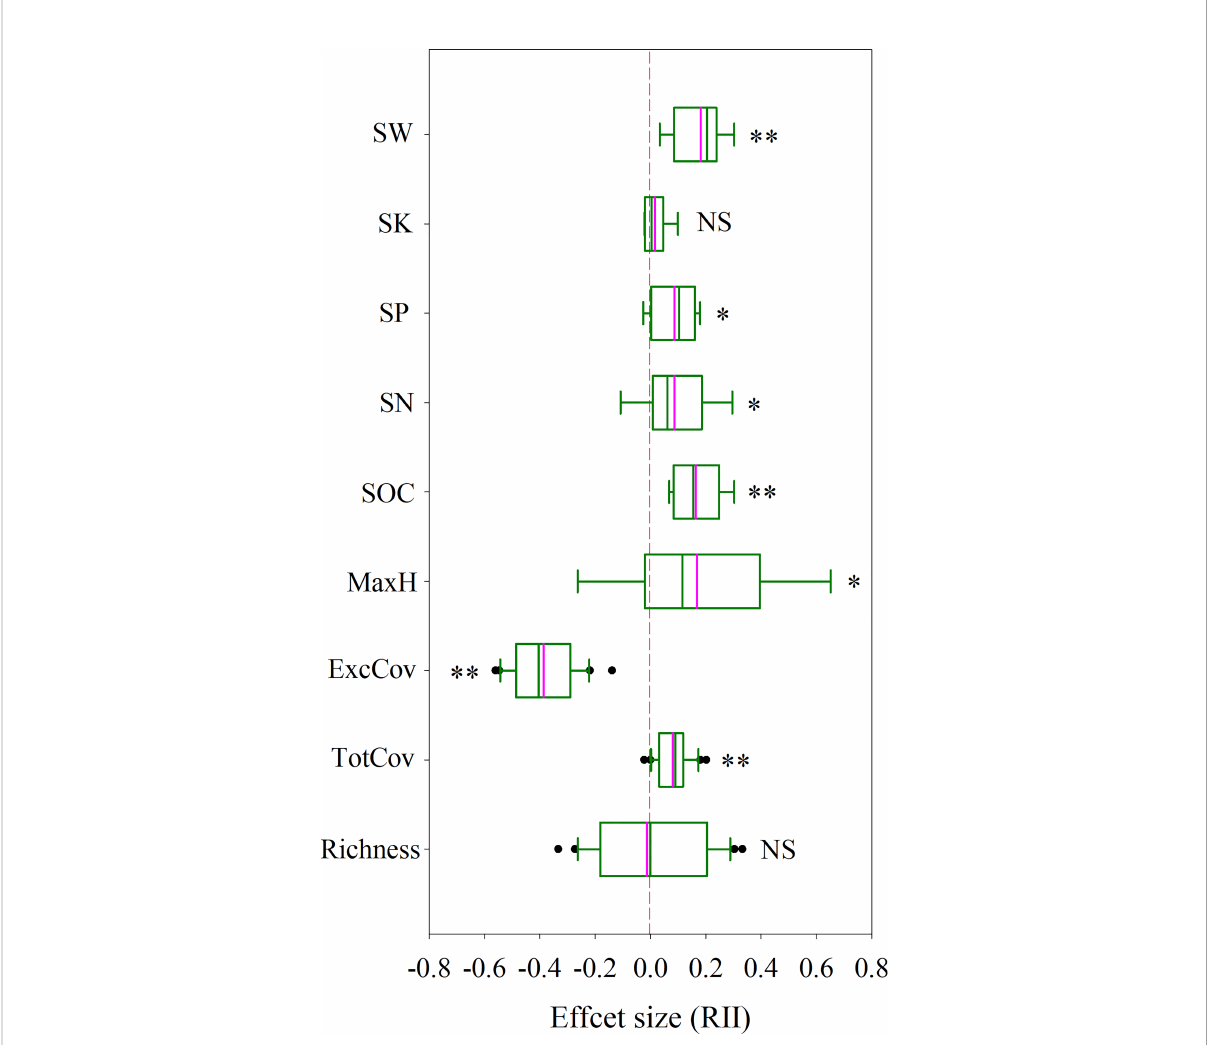
FIGURE 1 The effect size (RII) of P. kansuensis invasion on native community structure and soil environment in the sample sites. The pink line in the box diagram is the mean. Signi fi cant differences are reported from Mixed Linear Model as NS, P ≥ 0.05; *P < 0.05; **P < 0.01. Key: Richness, species richness; TotCov, total coverage of sample communities; ExcCov, coverage of sample communities excluding P. kansuensis ; MaxH, maximum height of sample community; SOC, soil organic carbon content in sample sites; SN, soil total nitrogen content; SP, soil total phosphorus content; SK, soil total potassium content; SW, soil water